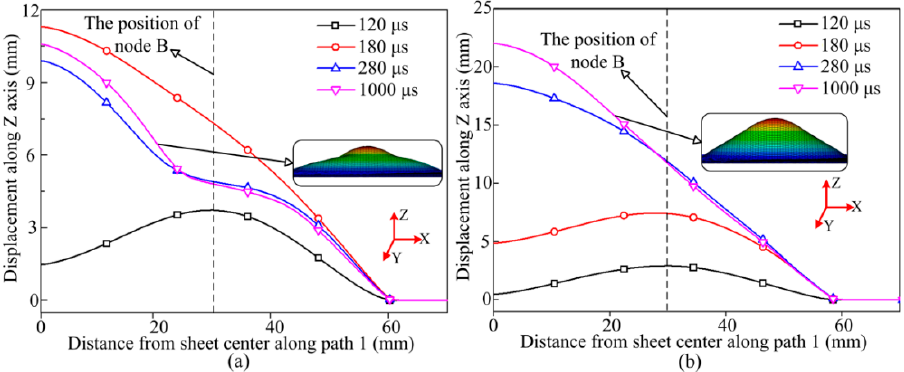
Figure 11. Deformation profile of sheet material at different time points during the forming process at different temperatures: ( a ) 200 °C; ( b ) 400 °C.